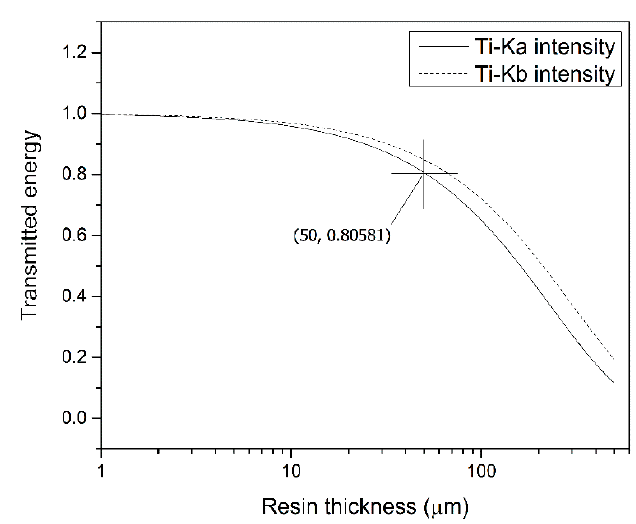
Figure 4. Transmission of Ti-K α and Ti-K β lines through a resin layer (11 wt% H, 11 wt% O, and 78 wt% C).